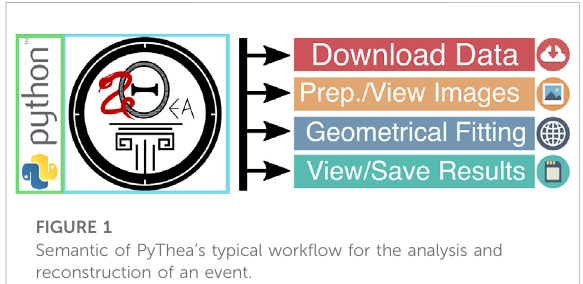
FIGURE 1 Semantic of PyThea ‘ s typical work fl ow for the analysis and reconstruction of an